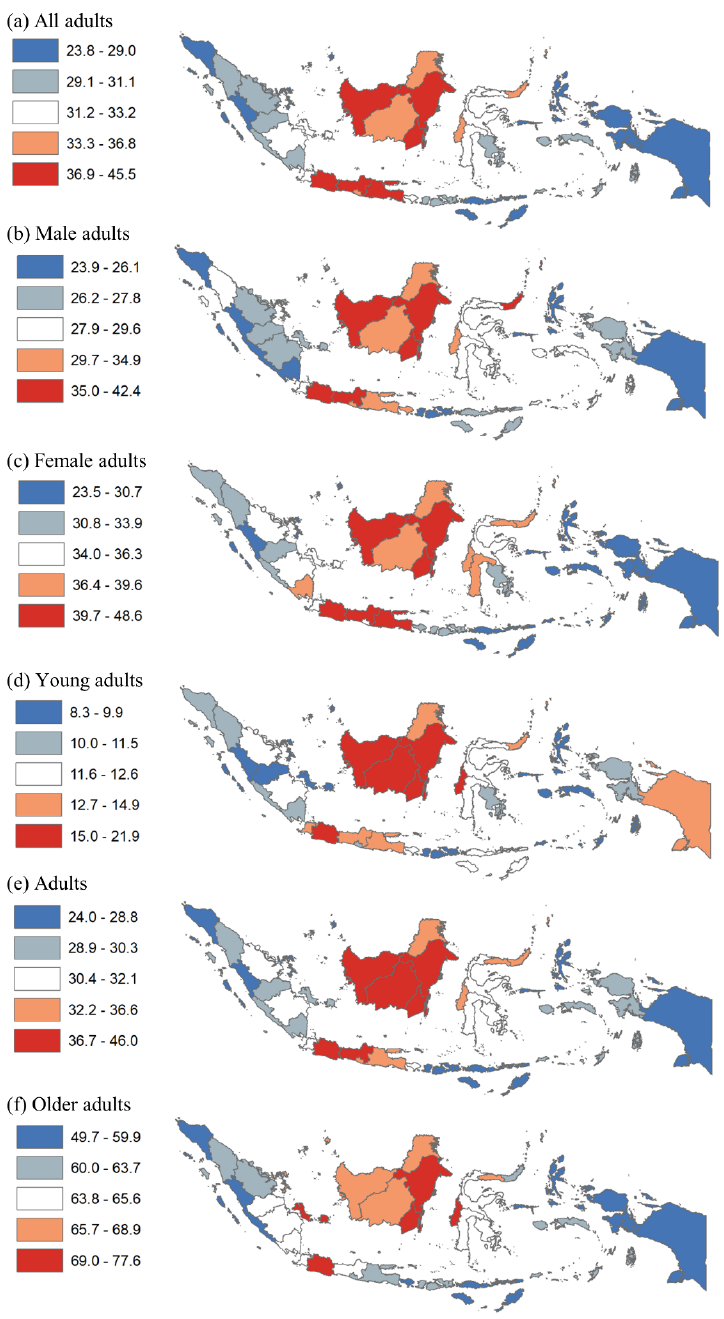
Figure 1. Disparity of hypertension among adults by province in Indonesia, 2018. Note: Numbers show the prevalence of hypertension among all adults, males, females, young adults, adults, and older adults.